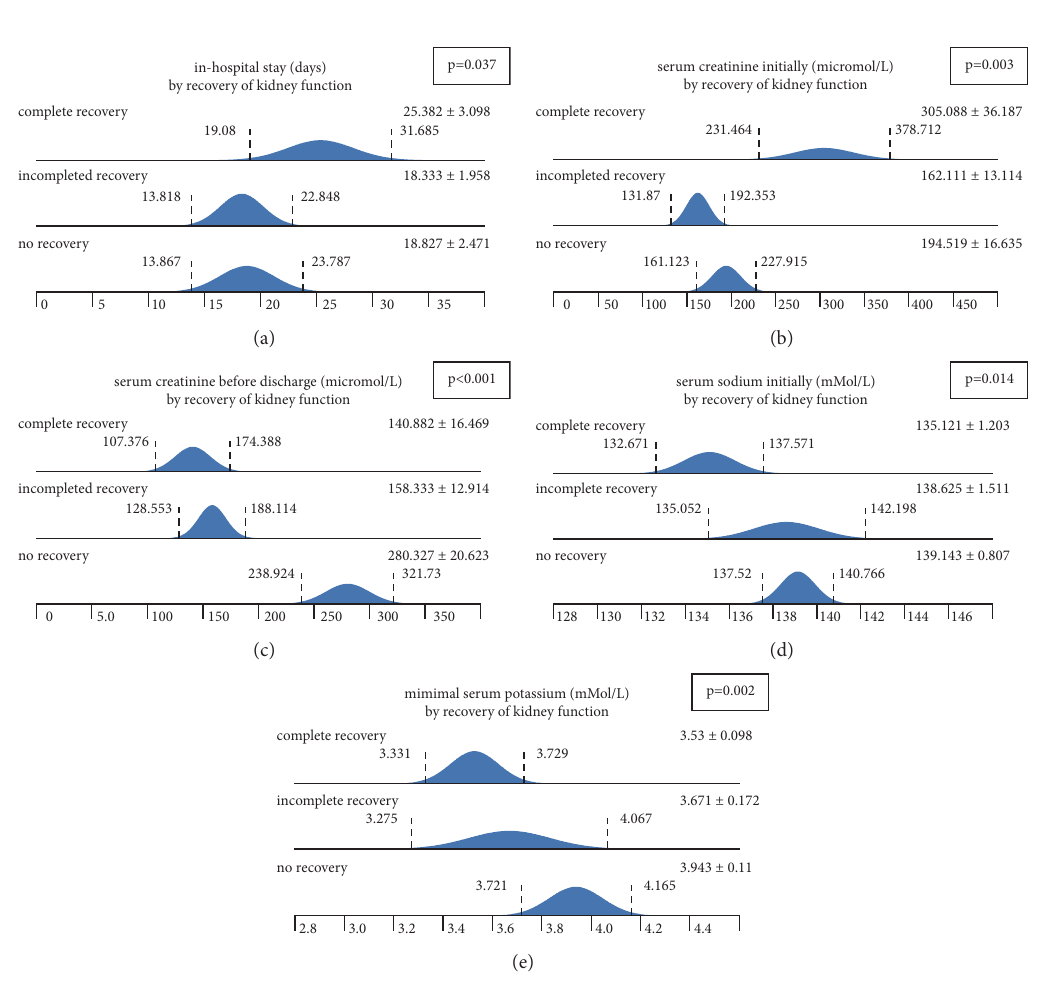
Figure 3: Five variables differed between the subcategories ‘no recovery,’ ‘incomplete recovery,’ and ‘complete recovery.’ (a) In-hospital treatment time (longest period in subjects with complete recovery). (b) Initial serum creatinine sodium (highest concentration in subjects with complete recovery). (c) Serum creatinine before discharge (highest concentration in subjects without recovery). (d) Serum sodium initially (lowest concentration in the ‘complete recovery’ subgroup). (e) Minimal serum potassium (lowest concentration in subjects with complete recovery) (data are represented as mean+/ −